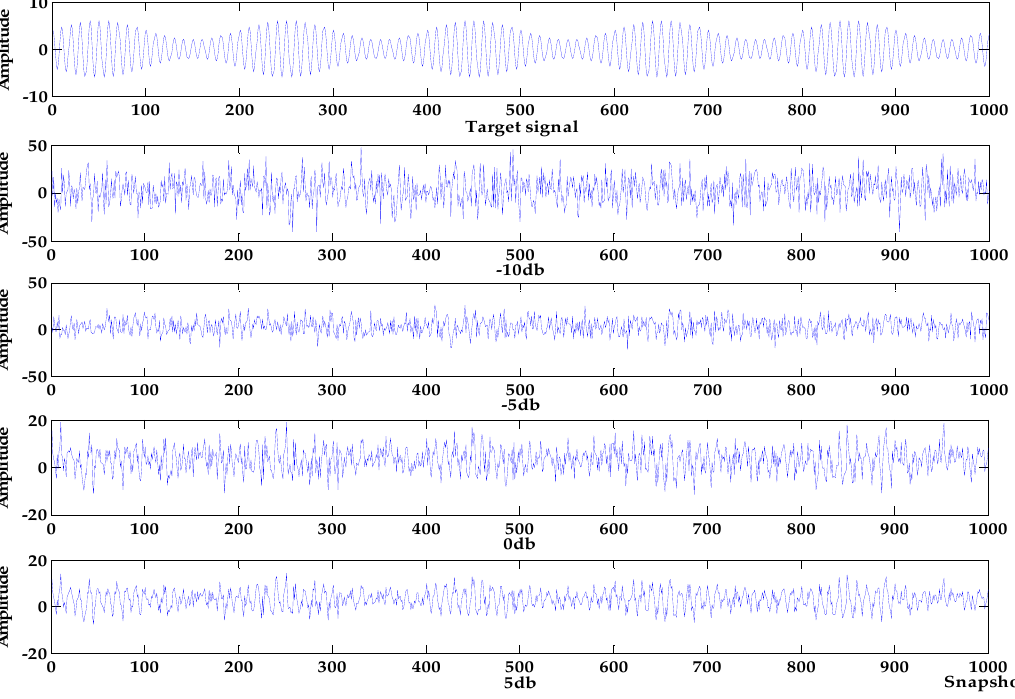
Figure 7. Target signal and simulated signal.